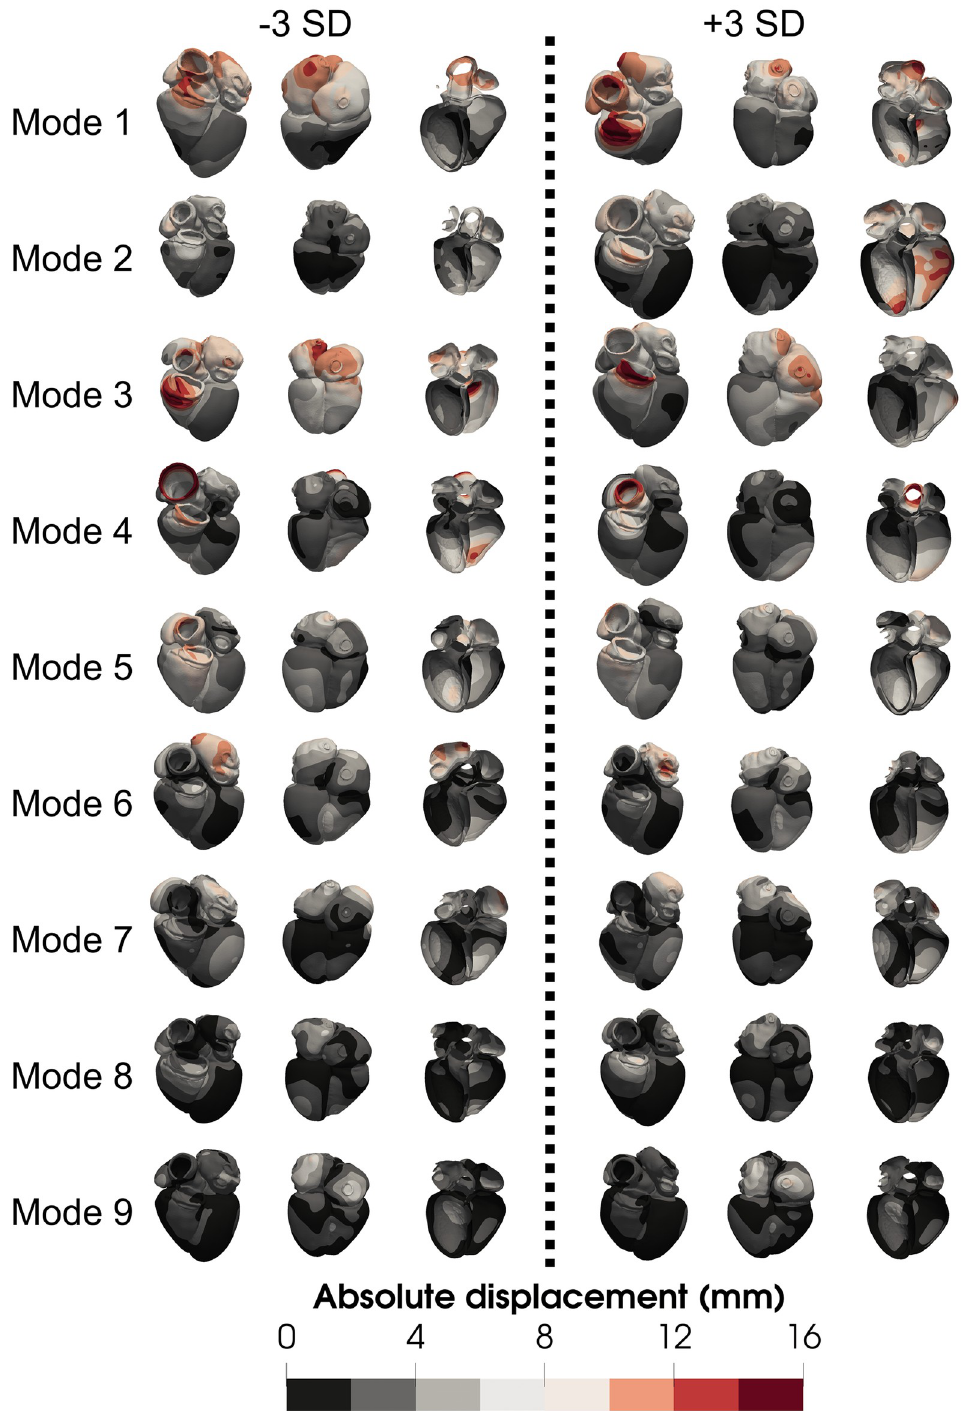
Fig 5. Visual representation of the first 9 modes of the PCA, scaled. Meshes correspond to the extreme3 cohort colour-coded with their distance with respect to the average mesh.